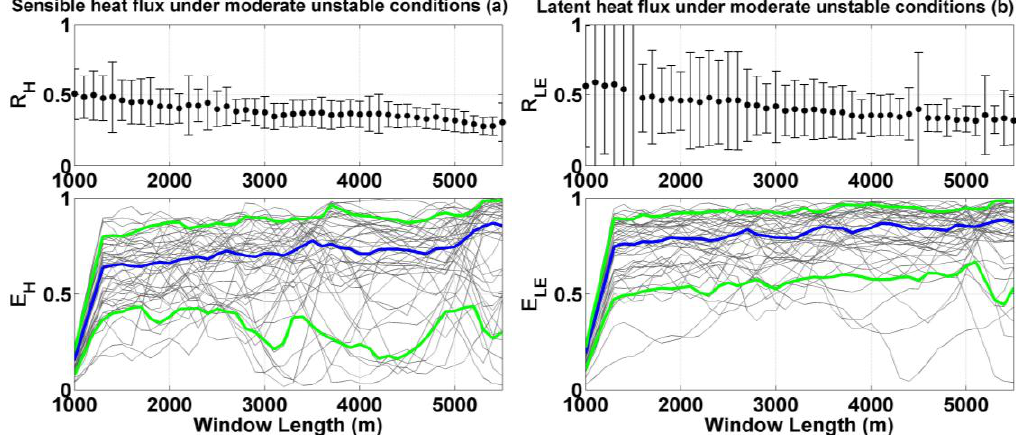
Figure 8. Averaged relative flux uncertainties ( R H , R LE ) with standard deviation ( top panels) and block ensemble averaged non-dimensional flux ( E H , E LE ) ( bottom panels) for sensible heat flux ( a ) and latent heat flux ( b ) under moderately unstable conditions. In the bottom panel, the solid blue curves represent the median value, while the solid green lines depict the 10th (lower) and 90th (upper) percentiles.